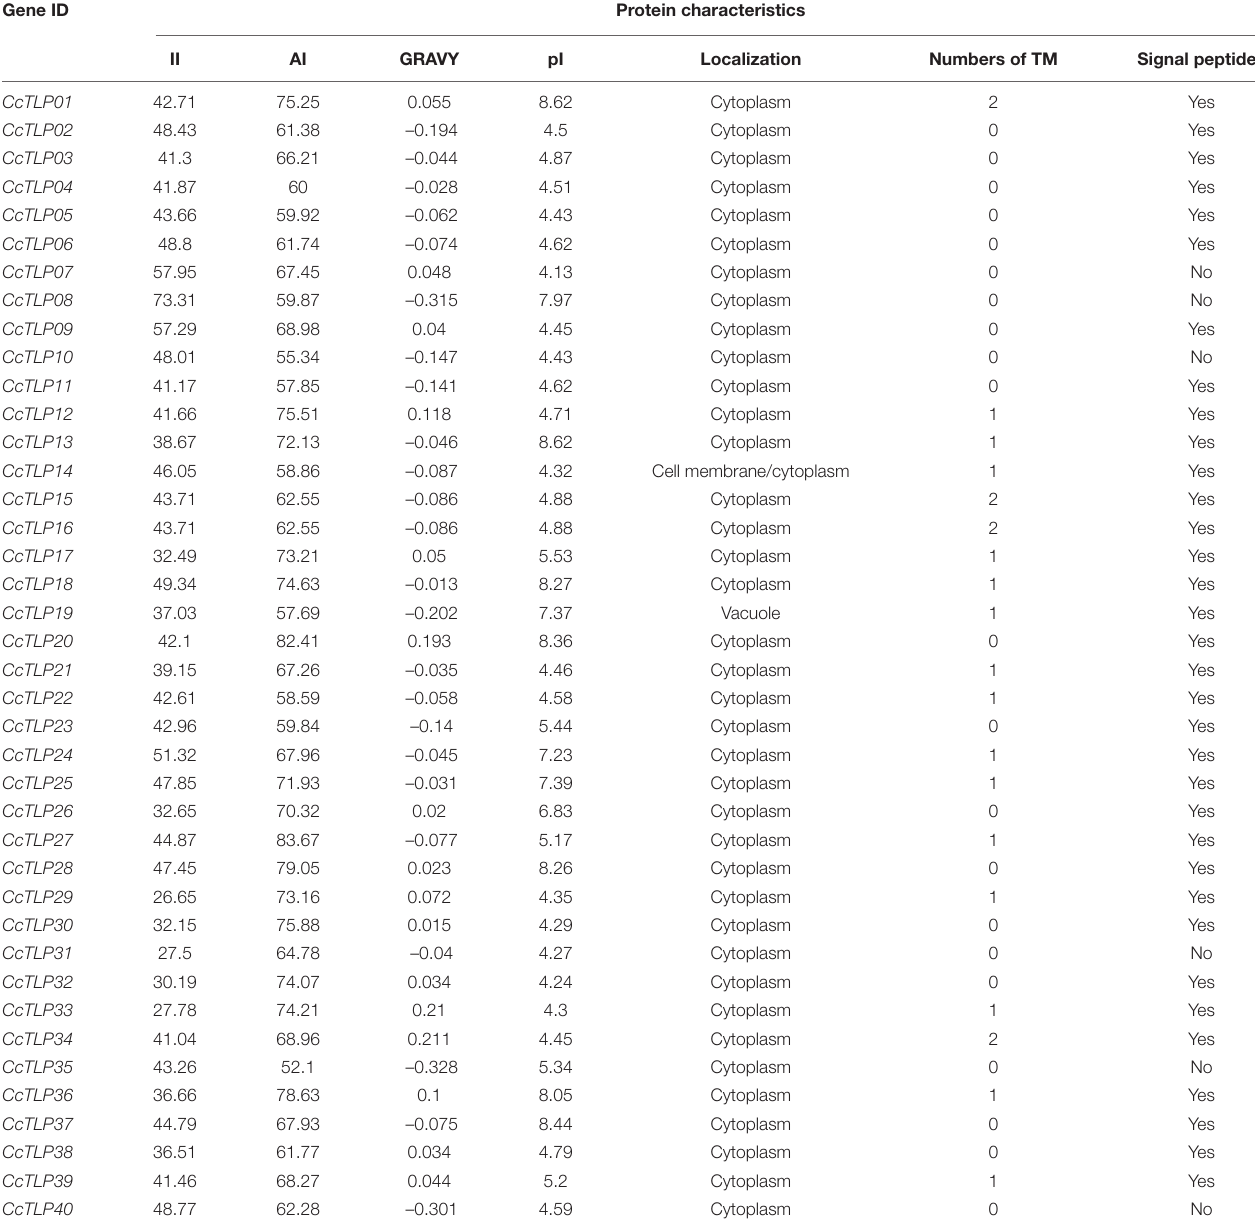
TABLE 2 | Protein features of TLP gene family in